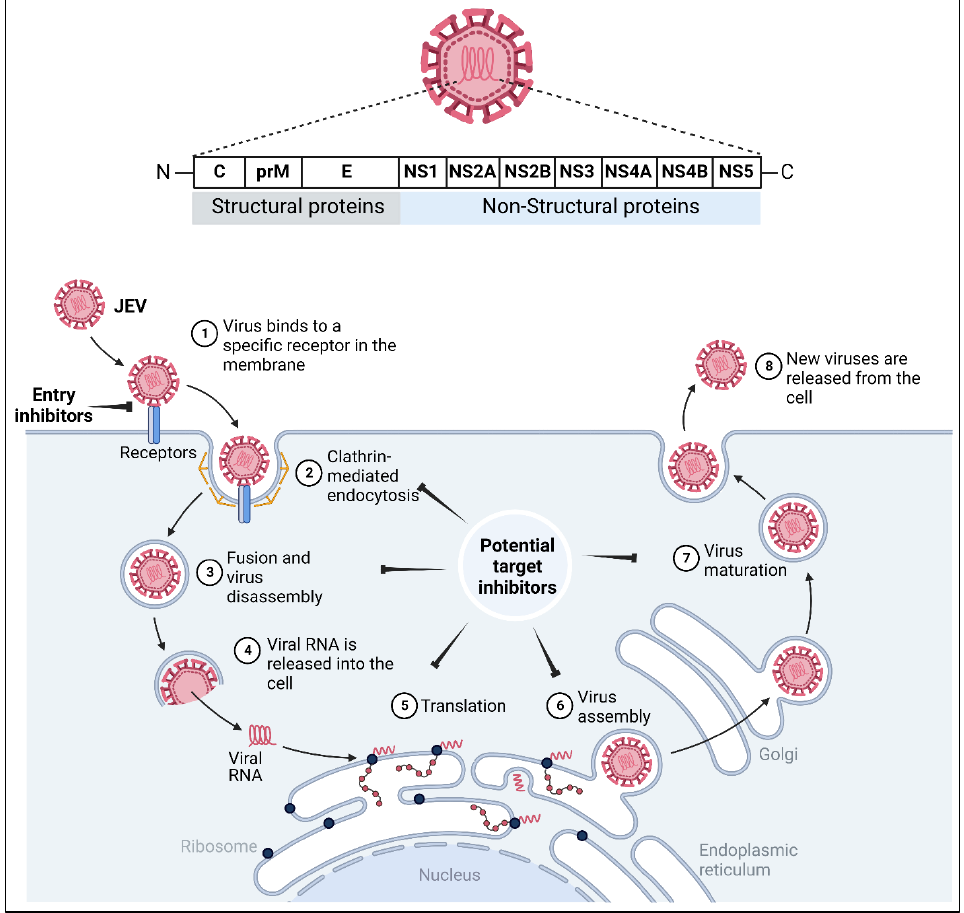
Figure 4. JEV structure, pathogenesis and potential drug targets. Schematic representation of JEV, comprising three structural proteins, namely capsid (C), precursor membrane (prM) and envelope (E), and seven non-structural (NS) proteins, NS1, NS2A, NS2B, NS3, NS4A, NS4B and NS5. N and